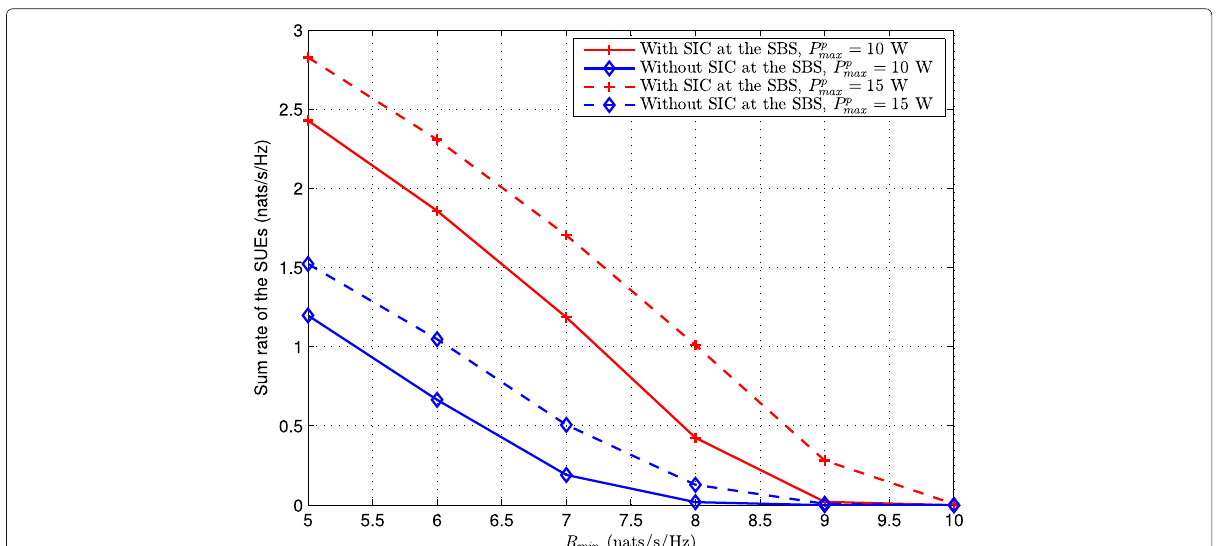
Fig. 3 SUE sum rate against R